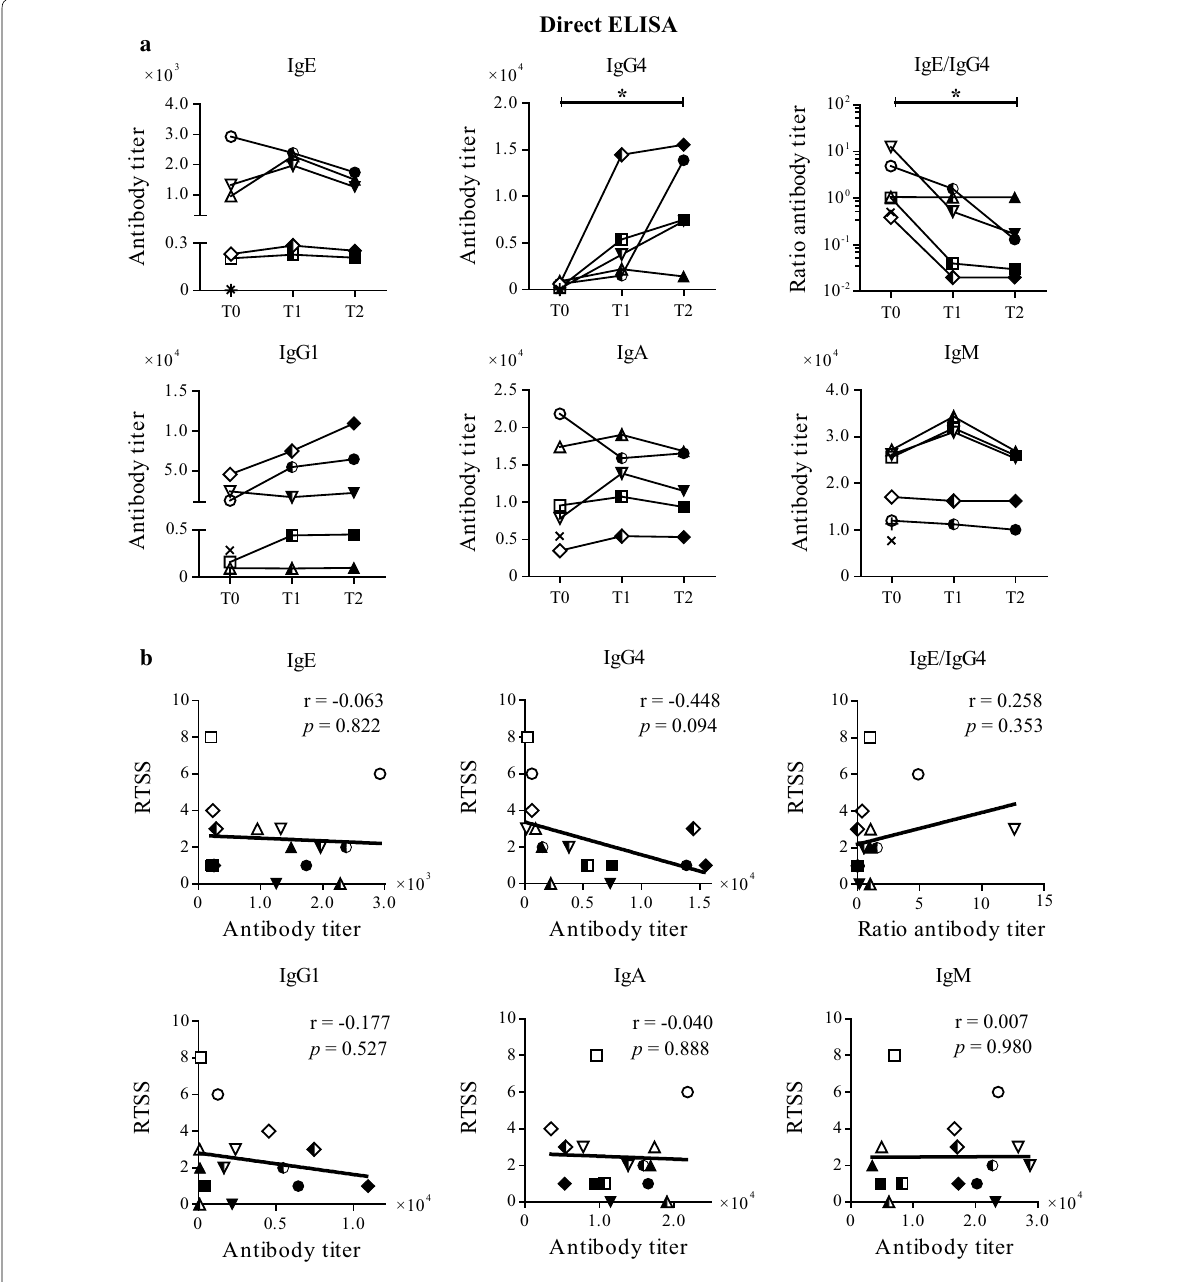
Fig. 3 Bet v 1-specific serum antibody titer during AIT and in control sera analyzed by ELISA. a Therapy-related changes in antibody subclass titer. Statistics were performed with Friedman and Dunn’s post test. * p < 0.05. b Correlation of antibody titer with RTSS. Serum samples were obtained at three different time points (T0, open; T1, semi-filled; T2, filled